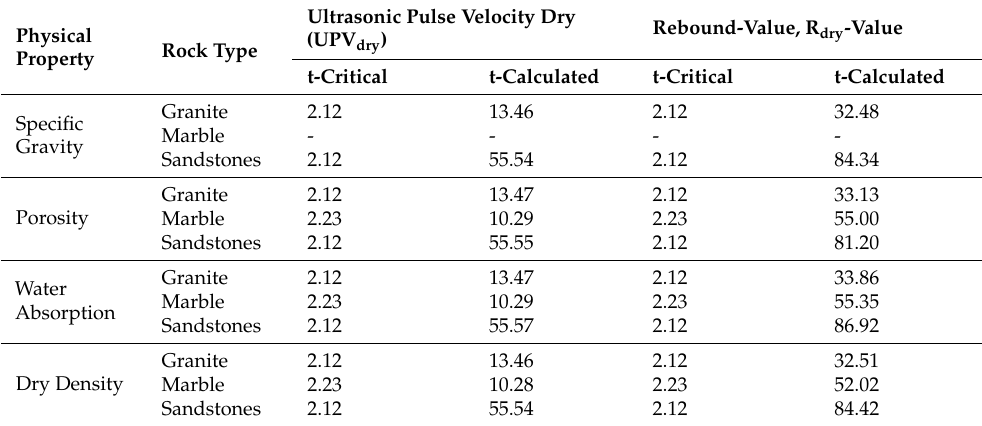
Table 7. Results of the t -test for the correlation of UPV (dry) and R-(dry) against the physical properties of the studied